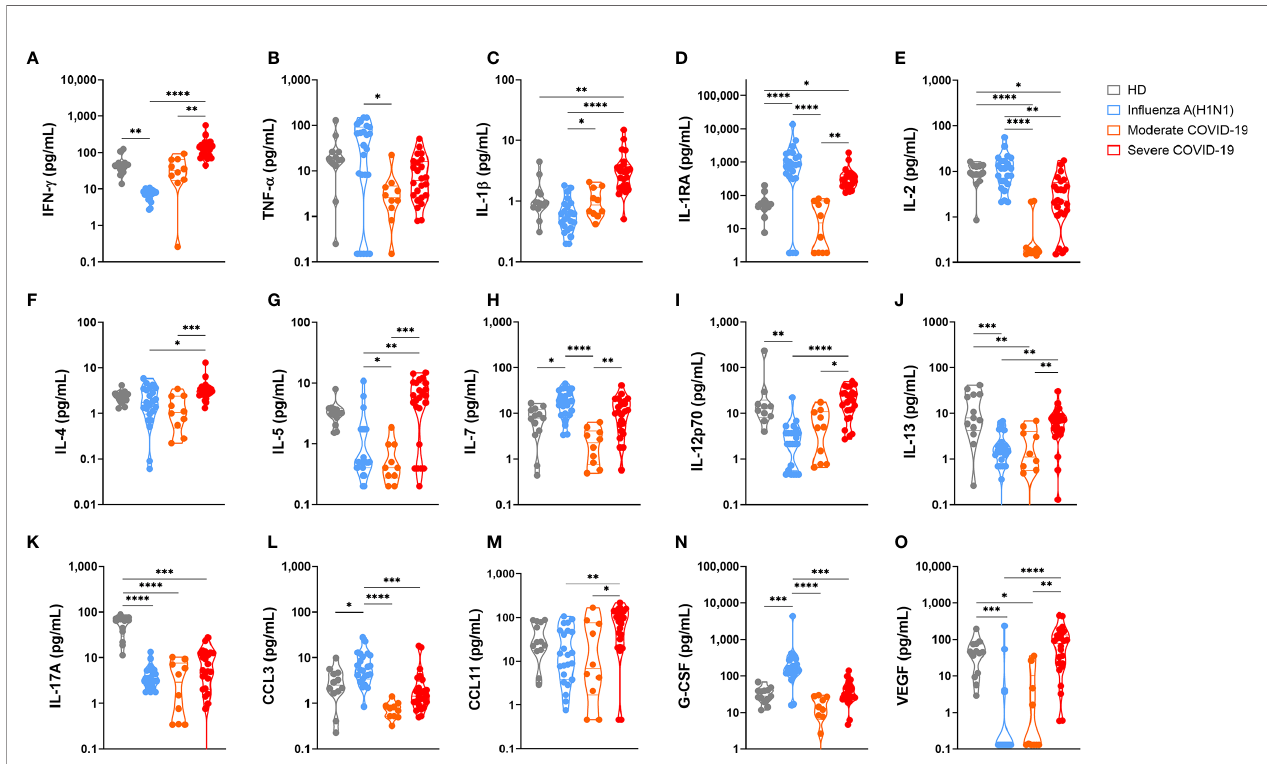
FIGURE 1 | Serum cytokine levels in pandemic in fl uenza A(H1N1) and COVID-19 patients. Serum levels of cytokines, chemokines, and growth factors in healthy volunteer donors (HD, n=13), patients with COVID-19 (n=10 moderate, 24 severe), and in fl uenza (n=23), were assessed by Luminex assay. Violin plots display medians and interquartile ranges (IQR). Differences between groups we estimated using the Kruskal-Wallis test with post hoc Dunn´s test. Signi fi cant differences are denoted by bars and asterisks: *p ≤ 0.05, **p ≤ 0.01, ***p ≤ 0.001, ****p ≤ 0.0001. (A) IFN- g , interferon-gamma; (B) TNF- a , tumor necrosis factor-alpha; (C) IL-1 b , interleukin 1beta; (D) IL-1RA, interleukin 1 receptor antagonist; (E) IL-2, interleukin 2; (F) IL-4, interleukin 4; (G) IL-5, interleukin 5; (H) IL-7, interleukin 7; (I) IL-12p70, interleukin 12 p70 subunit; (J) IL-13, interleukin 13; (K) IL-17A, interleukin 17A; (L) CCL3, C-C motif chemokine ligand 3; (M) CCL11, C-C motif chemokine ligand 11; (N) G-CSF, granulocyte colony-stimulating factor; (O) VEGF, vascular endothelial growth